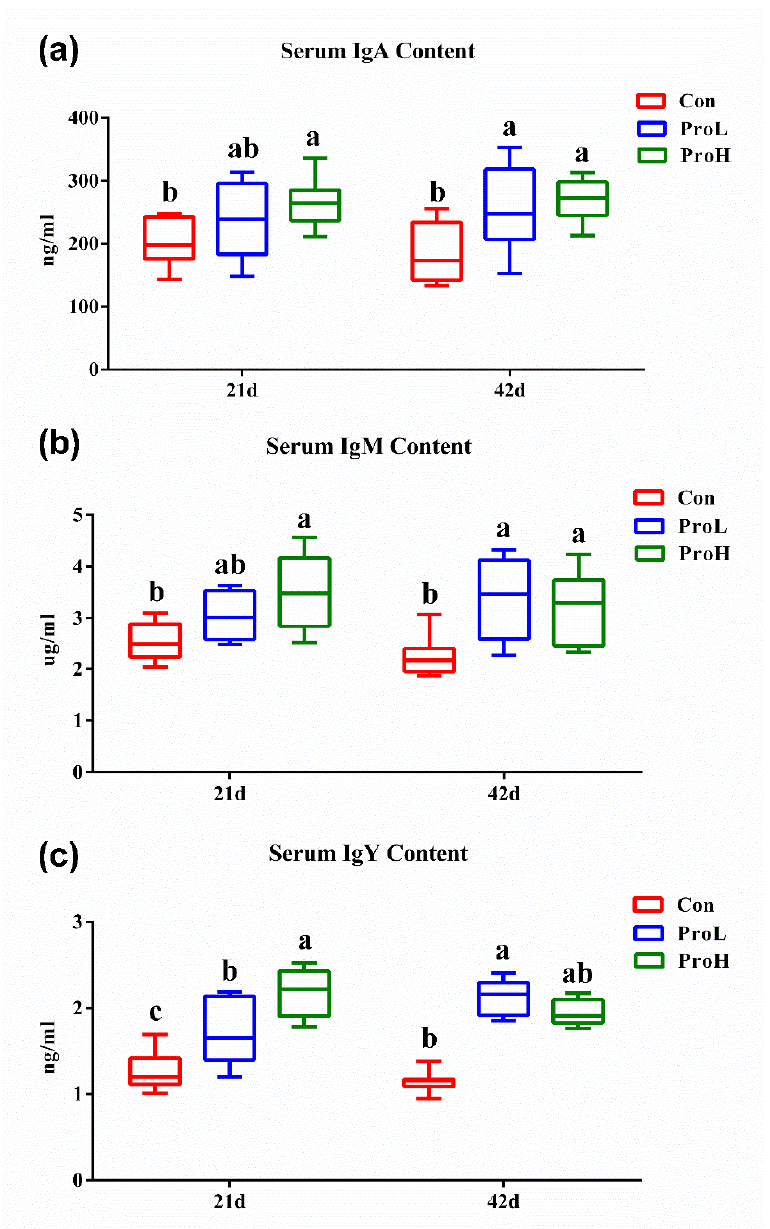
Figure 3. Effects of compound probiotic supplementation on serum IgA, IgM, and IgY contents. ( a ) serum IgA; ( b ) serum IgM; ( c ) serum IgY. a, b, and c in the same figure represent significant difference ( p < 0.05). Con birds were fed a basal diet; ProL birds were fed a basal diet added into 10 10 probiotics cfu/kg; ProH birds were fed a basal diet added into 10 11 probiotics cfu/kg ( n = 8).